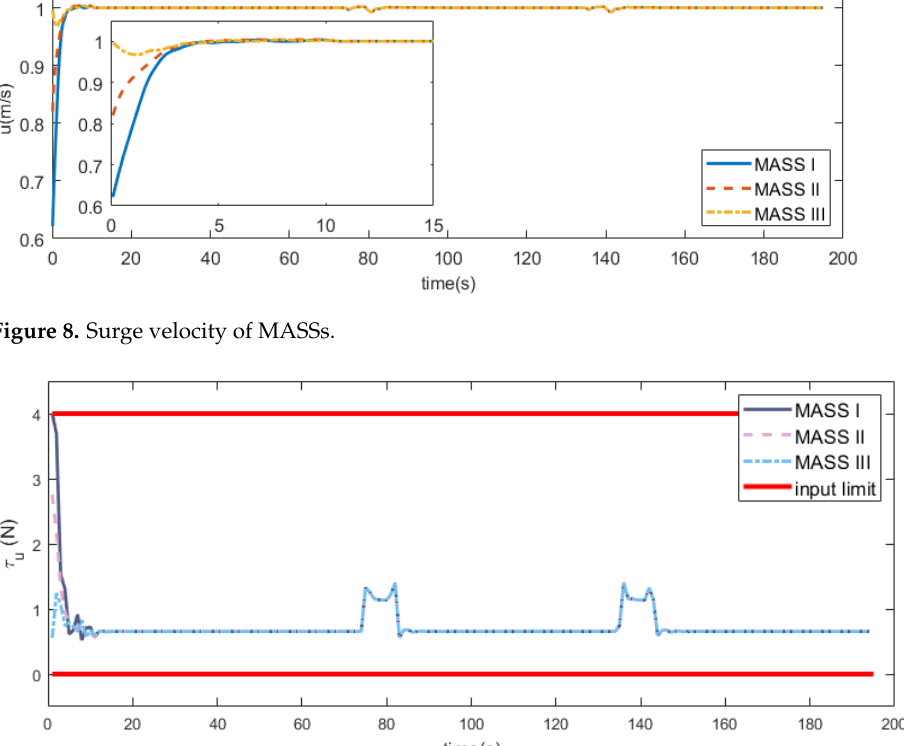
Figure 9. Heave thrust of MASSs.